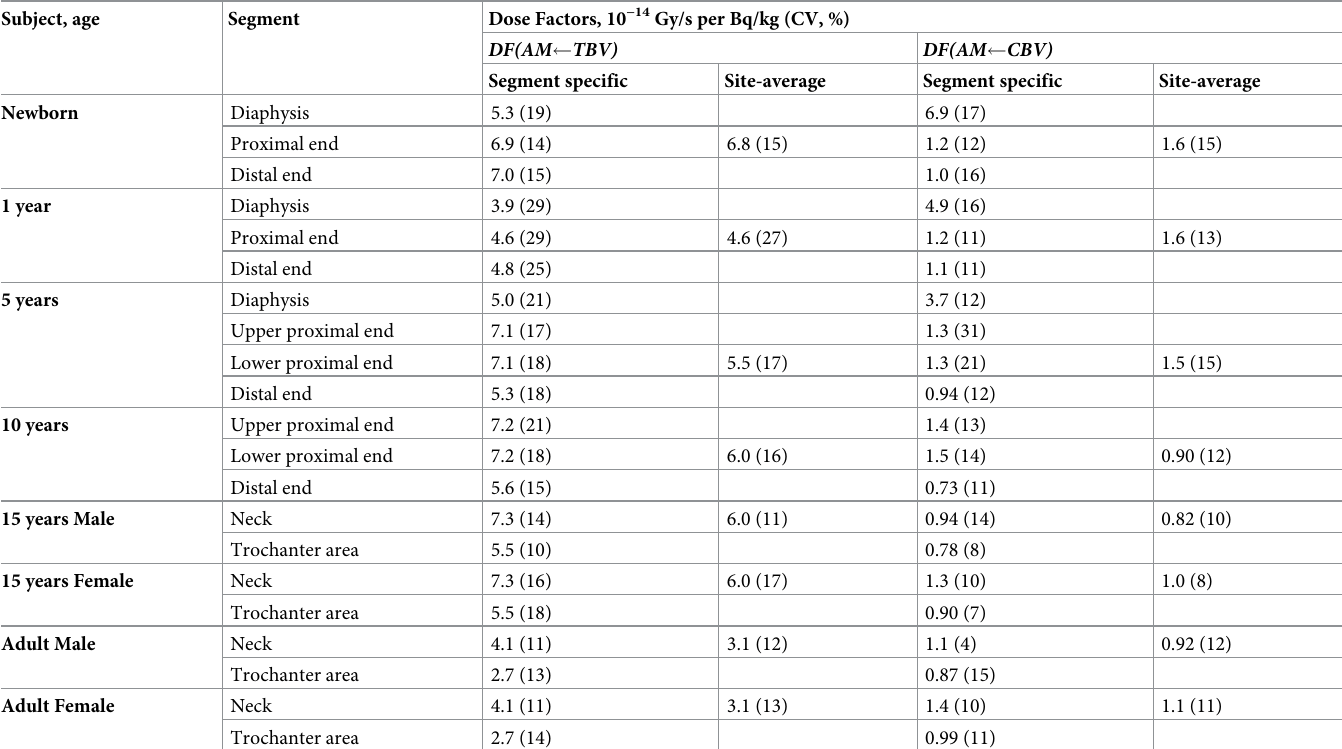
Table 7. Modeling results for human femur: DF(AM TBV) and DF(AM CBV) for 90 Sr+ 90 Y spectrum and their individual variability in terms of